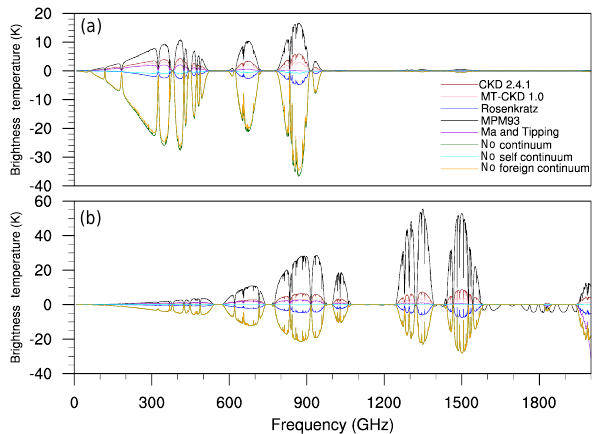
Figure 8. Spectral residuals between the downwelling brightness temperatures simulated with various continuum parameterisations available in ARTS and the configuration used throughout this study (MT-CKD 2.5.2) for (a) annual mean and (b) < 10% PWV scenar- ios at Summit, Greenland. Zenith angle=0 ◦ .